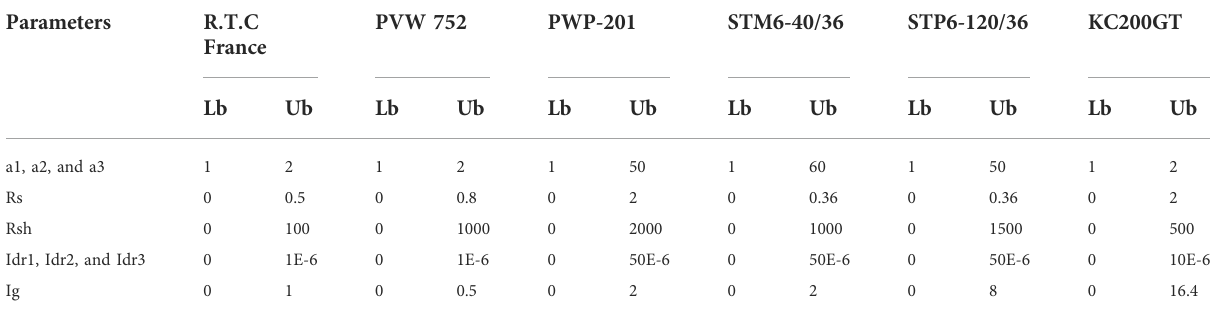
TABLE 1 Lower and upper bounds of different PV cells/panels. Parameters